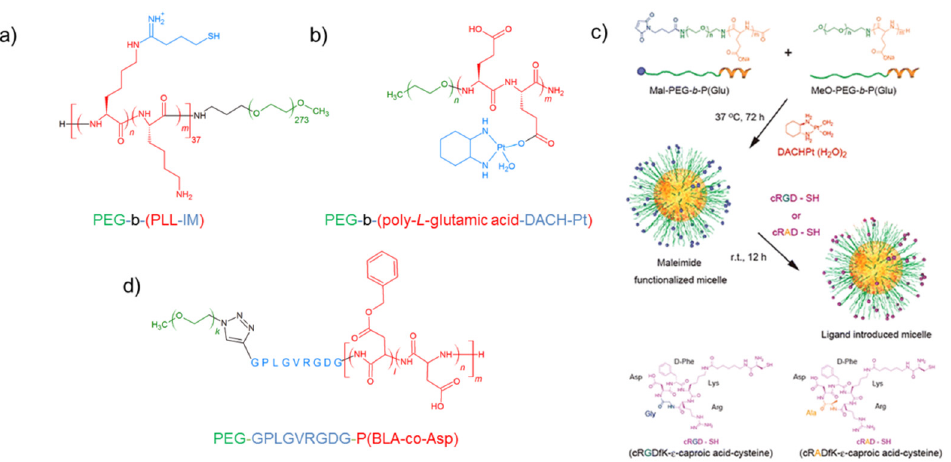
Figure 6. ( a ), ( b ), ( d ) Chemical formulas for some selected PEG-Poly( L -amino acid) micelle unimers; ( c ) scheme for the design and synthesis approach for ligand-linked DACHPt-containing micelles (reproduced with permission from [116]).